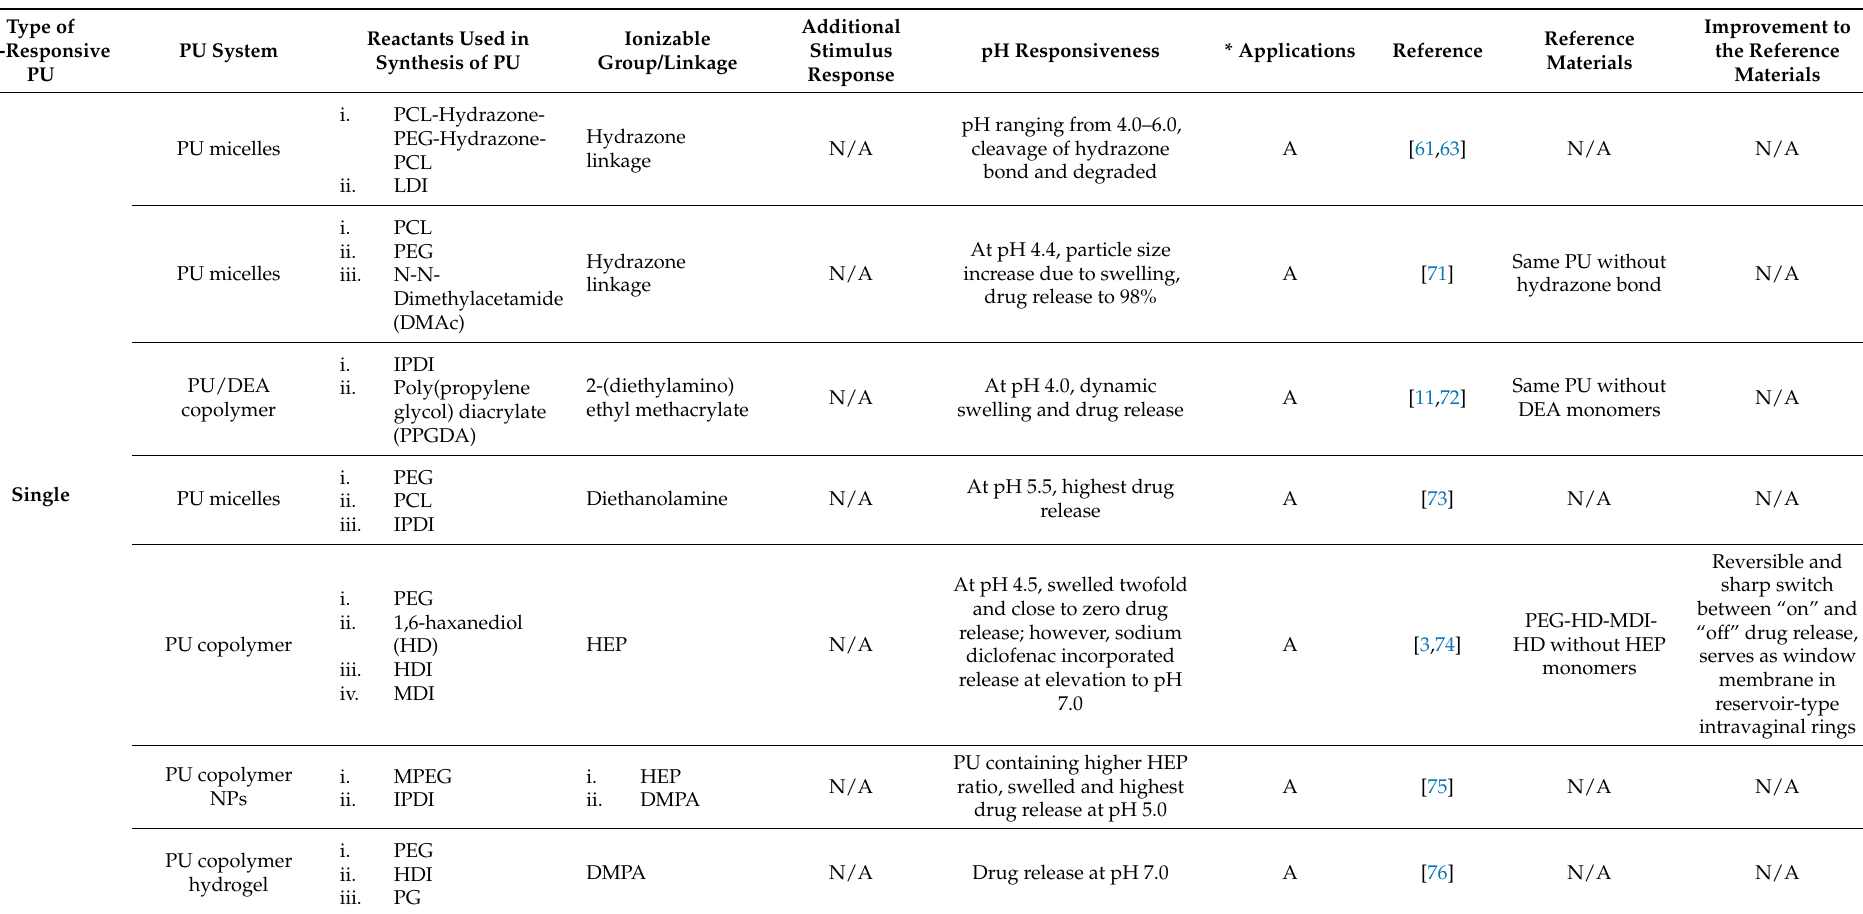
Table 3. Different types of pH-responsive PUs with their attached functional response groups and their different